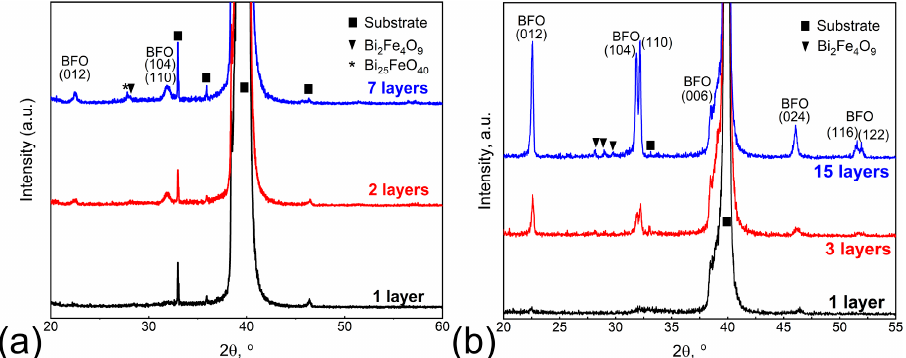
Figure 1. XRD diffractograms of the ( a ) HTD and ( b ) LTD BFO thin films with different numbers of the layers.